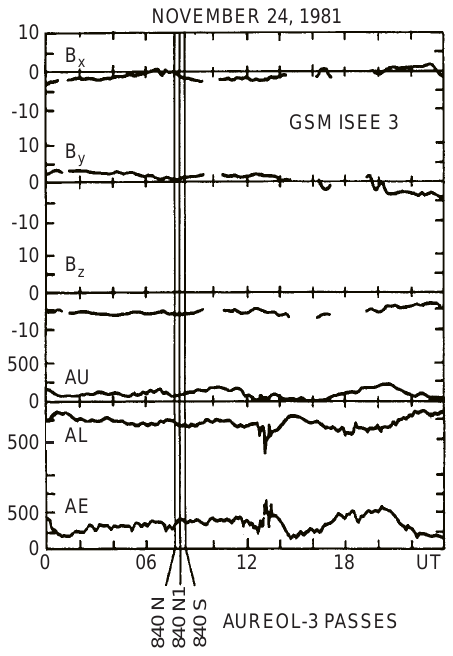
Fig. 1. Activity on November 24, 1981. From top to bottom : GSM components of the IMF measured by the ISEE-3 satellite; auroral electrojet indices, AU, AL, AE. The 3 AUREOL-3 passes relevant for this SMC study are indicated by vertical lines . (adapted from Yahnin et al .,